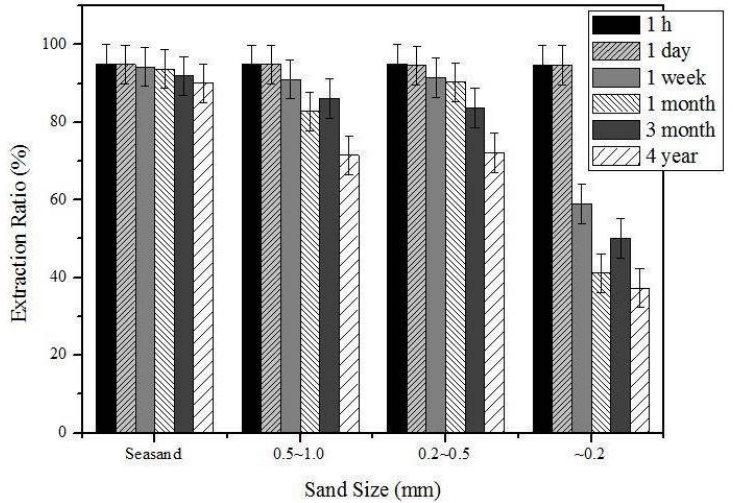
Figure 5. Extracted ratio changes according to soil type and the elapsed time after sample preparation (uncertainty applied: